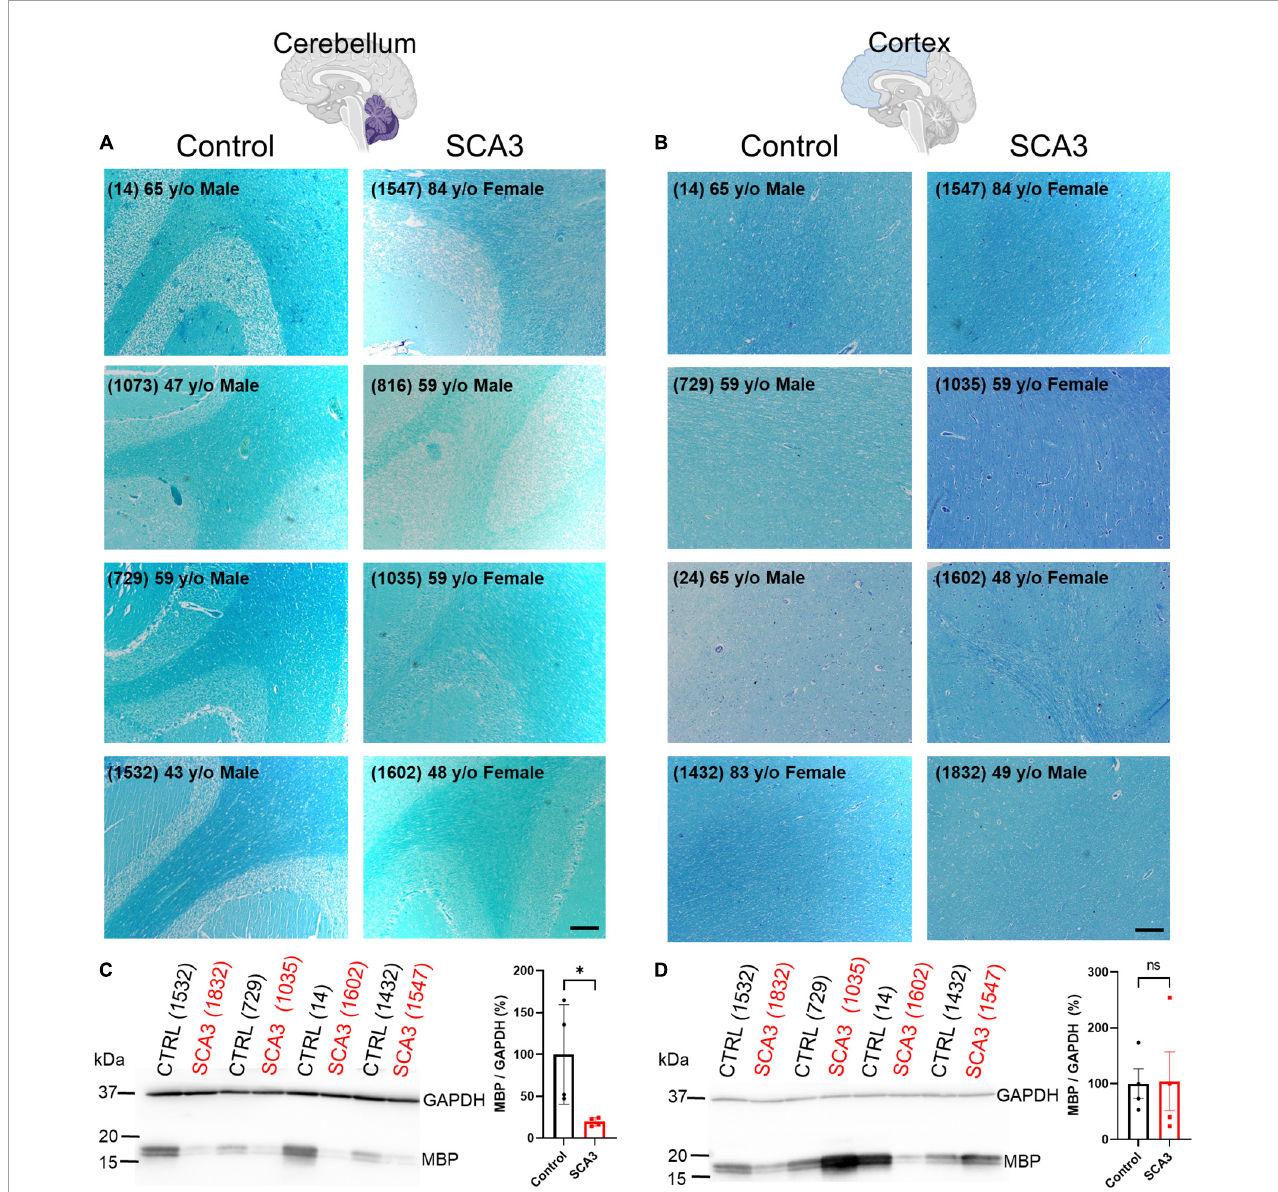
FIGURE1 Human post-mortem myelin staining is reduced in the cerebellum and unchanged in the frontal cortex of patients with SCA3 relative to control subject samples. Representative images show post-mortem human (A) cerebellum and (B) cortex stained with Luxol Fast Blue from controls subjects (left) relative to patients with SCA3 (right). Scale bar 200 µ m. Myelin basic protein (MBP) is significantly decreased in the cerebellum of SCA3 patients compared to approximately age-matched controls (C) , while MBP varies immensely and is not significantly different between SCA3 and control samples in the frontal cortex (D) . Student’s unpaired t -test performed after verifying normal distribution of data via the Shapiro–Wilk normality test. ∗ p <